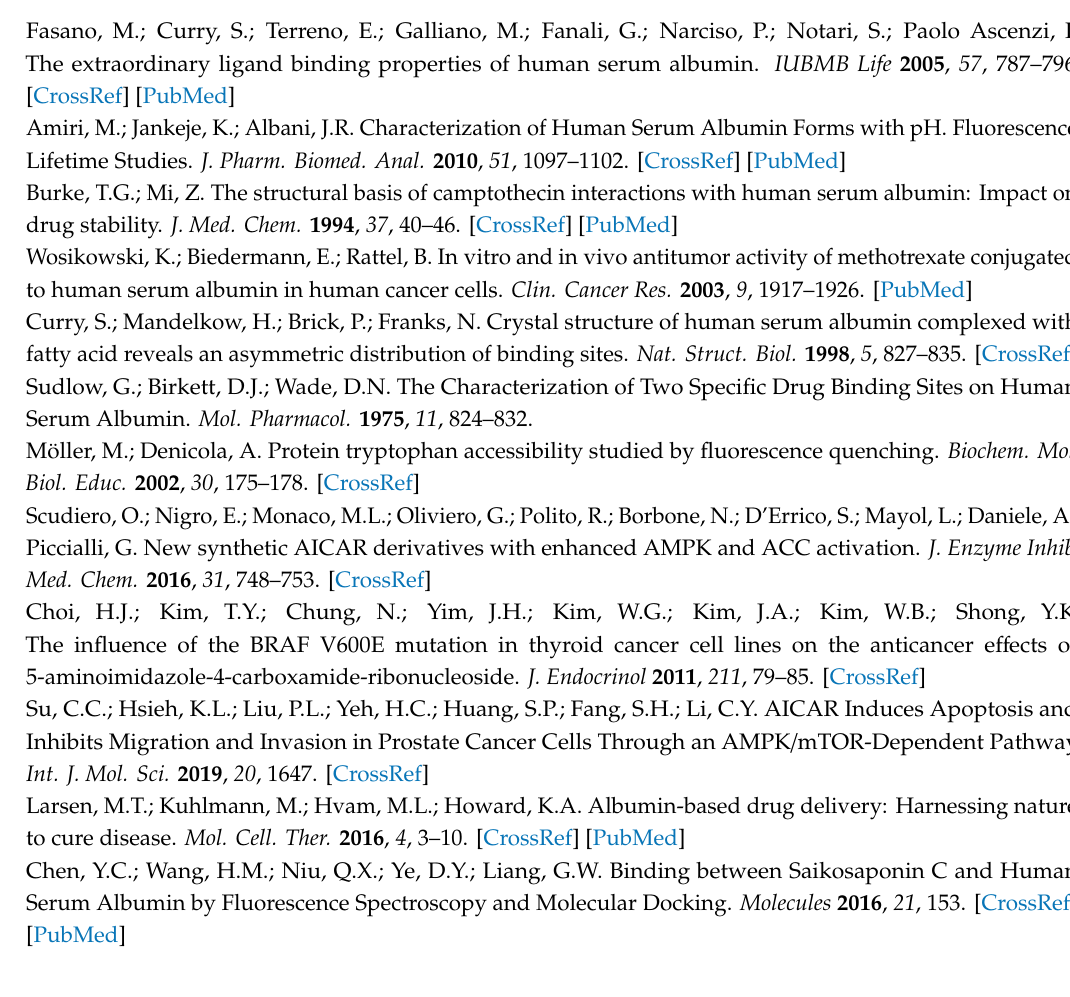
Supplementary Materials: The following are available online. Figure S1: The modular structural organization of HSA; Figure S2: 2D binding interaction map- AICAR in HSA site-II; Figure S3: 2D binding interaction map- AICAR in HSA site-I; Figure S4a: Electrostatic surface maps for bound AICAR in HSA Sudlow site-I & II; Figure S5a: HSA (PDB:ID 2BXD) bound AICAR Sudlow site-I; Figure S5b: HSA (PDB:ID 1N5U) bound AICAR Sudlow site-I; Figure S5c. Binding pocket VDW interaction Surface map bound HSA:AICAR; Figure S6a. HSA (PDB:ID 2BXG) bound AICAR Sudlow site-II; Figure S6b. HSA (PDB:ID 1N5U) bound AICAR Sudlow site-II; Figure S6c. Binding pocket VDW interaction Surface map, HSA (PDB:ID 1N5U) bound AICAR Sudlow site-II; Figure S7: Ribbon Rendition of AICAR bound to HSA Site-I (PDB ID: 1N5U); Figure S8: Ribbon Rendition of AICAR bound to HSA Site-II (PDB ID: